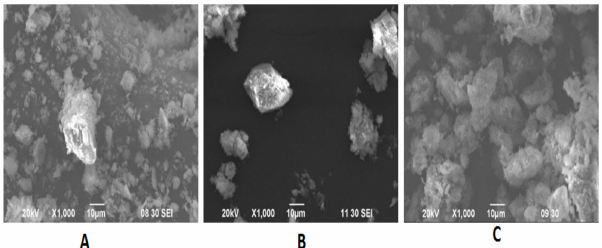
Figure 4. SEM images of ( A ) Raw clay at × 1000 magnification, ( B ) purified clay at × 1000 magnification, and ( C ) MC at × 1000